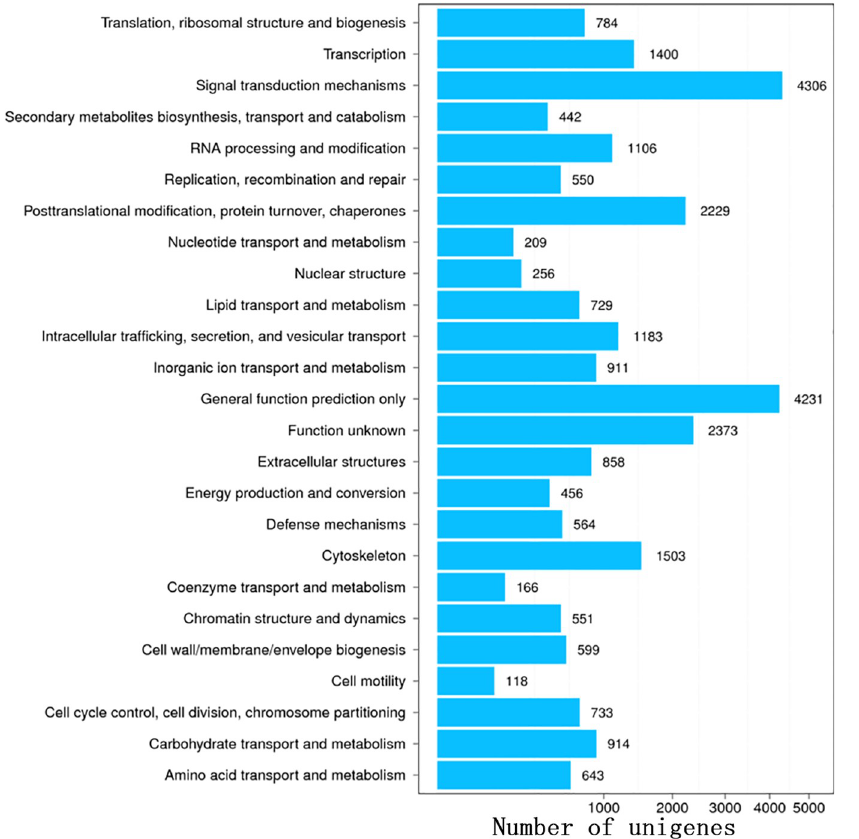
Fig 8. KOG annotation of the unigenes from P . viridis mantle